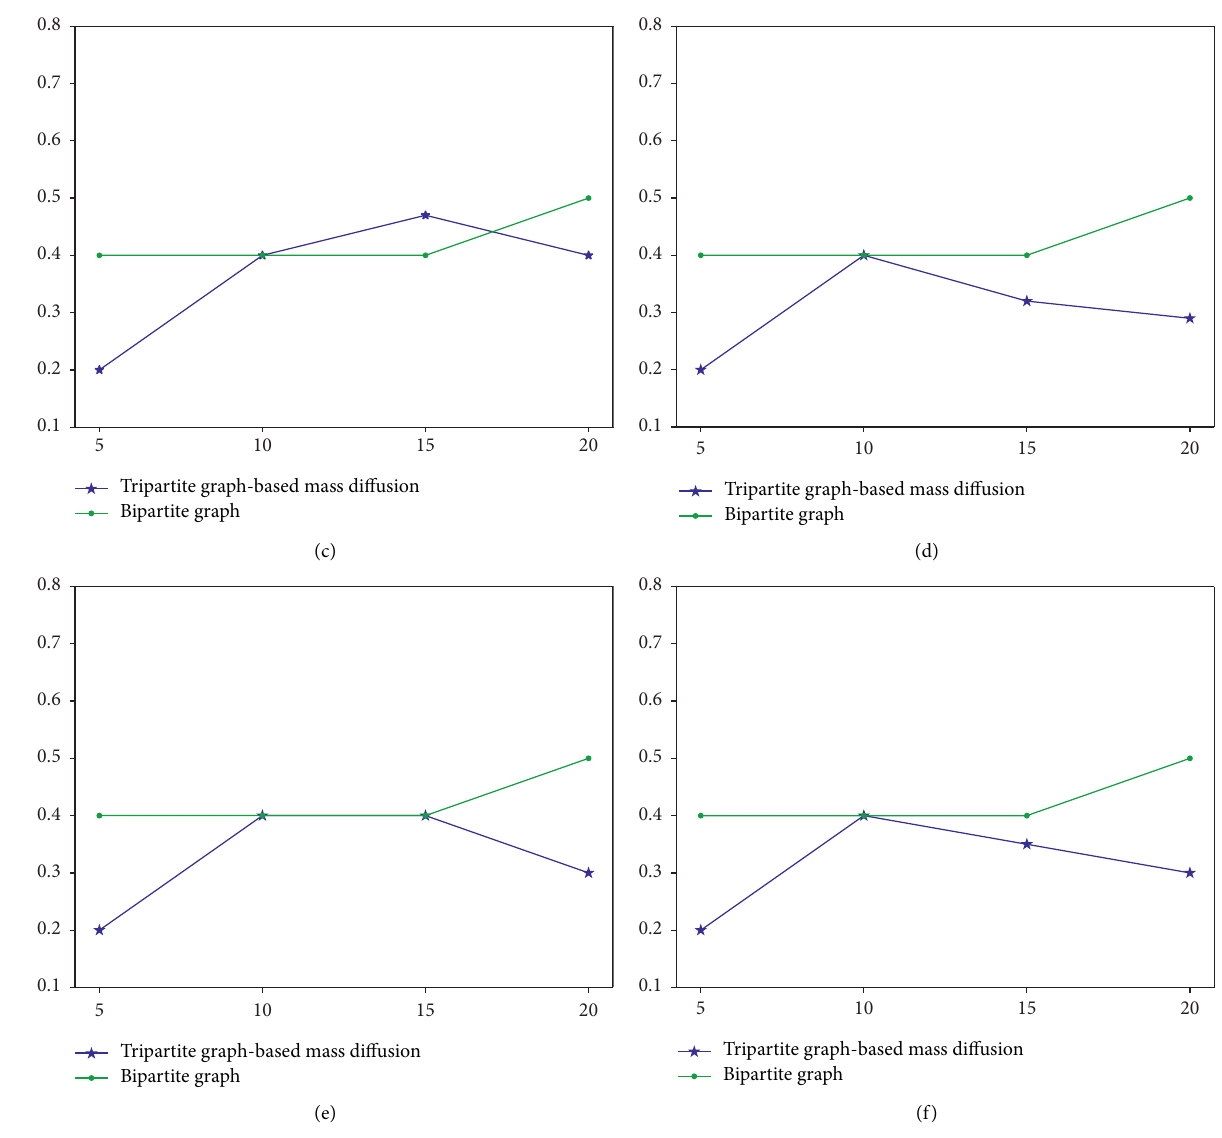
Figure 6: Precision of the hybrid model